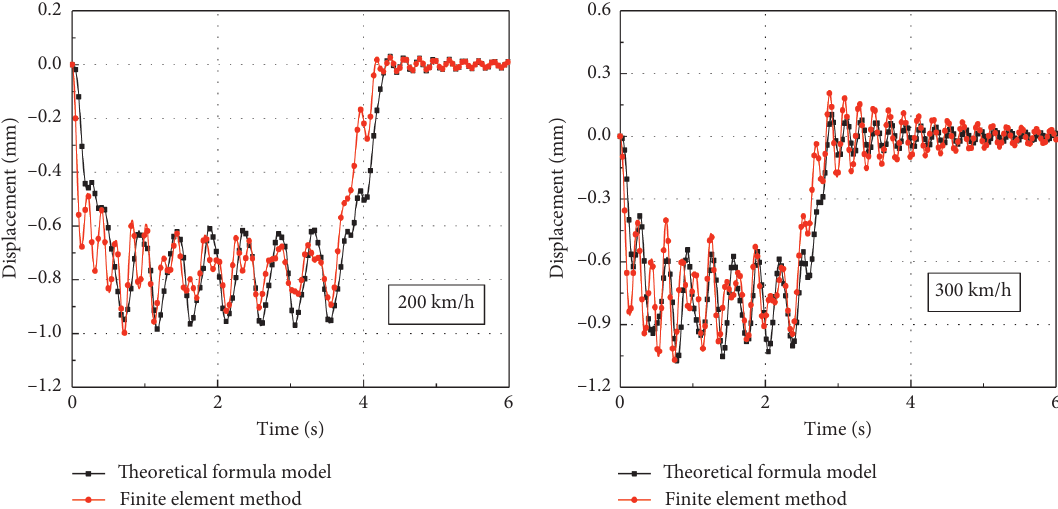
Figure 7: The displacement of the bridge midspan under the two models at a speed of 200km/h and